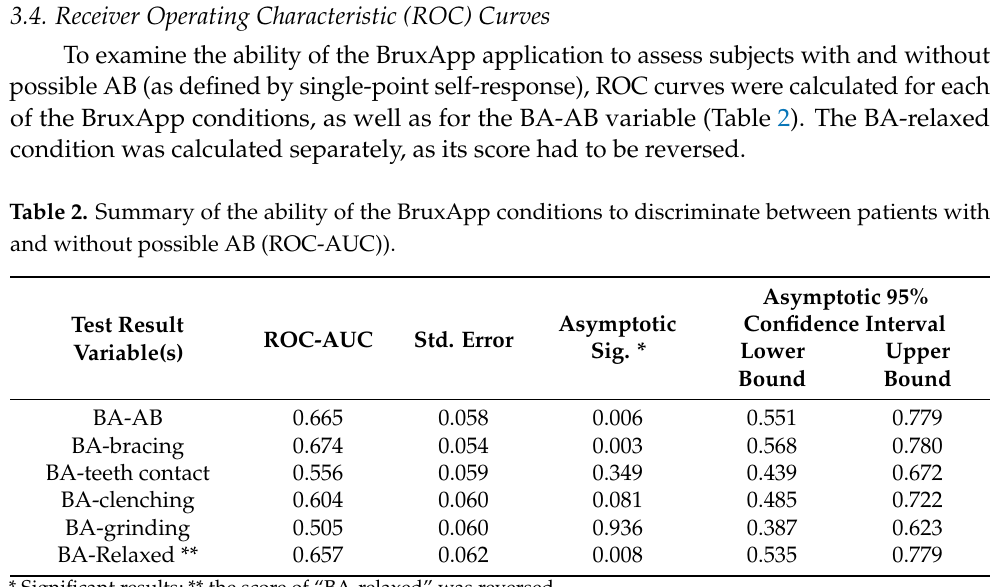
Table 2. Summary of the ability of the BruxApp conditions to discriminate between patients with and without possible AB (ROC-AUC)).